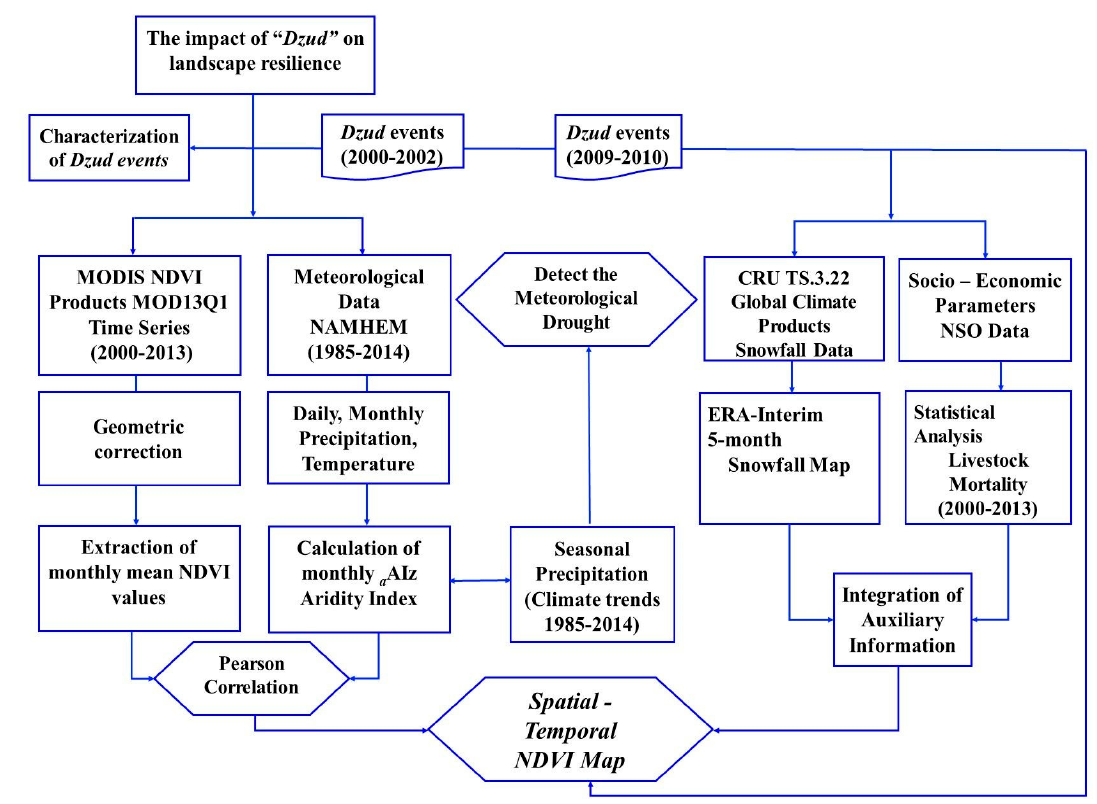
Figure 2. Schematic flow chart of Geographic Information System (GIS)–based dzud evaluation